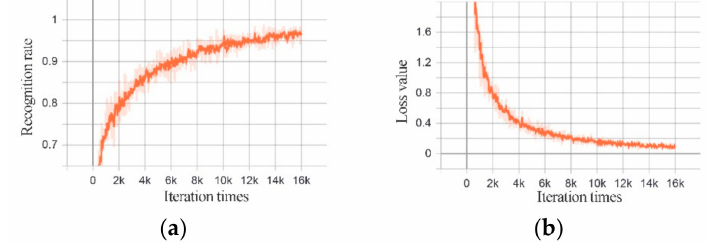
Figure 15. MFIJD model structure 2 training process. ( a ) The change of recognition rate of training set with the number of iterations. ( b ) The change of loss function with the number of iterations.